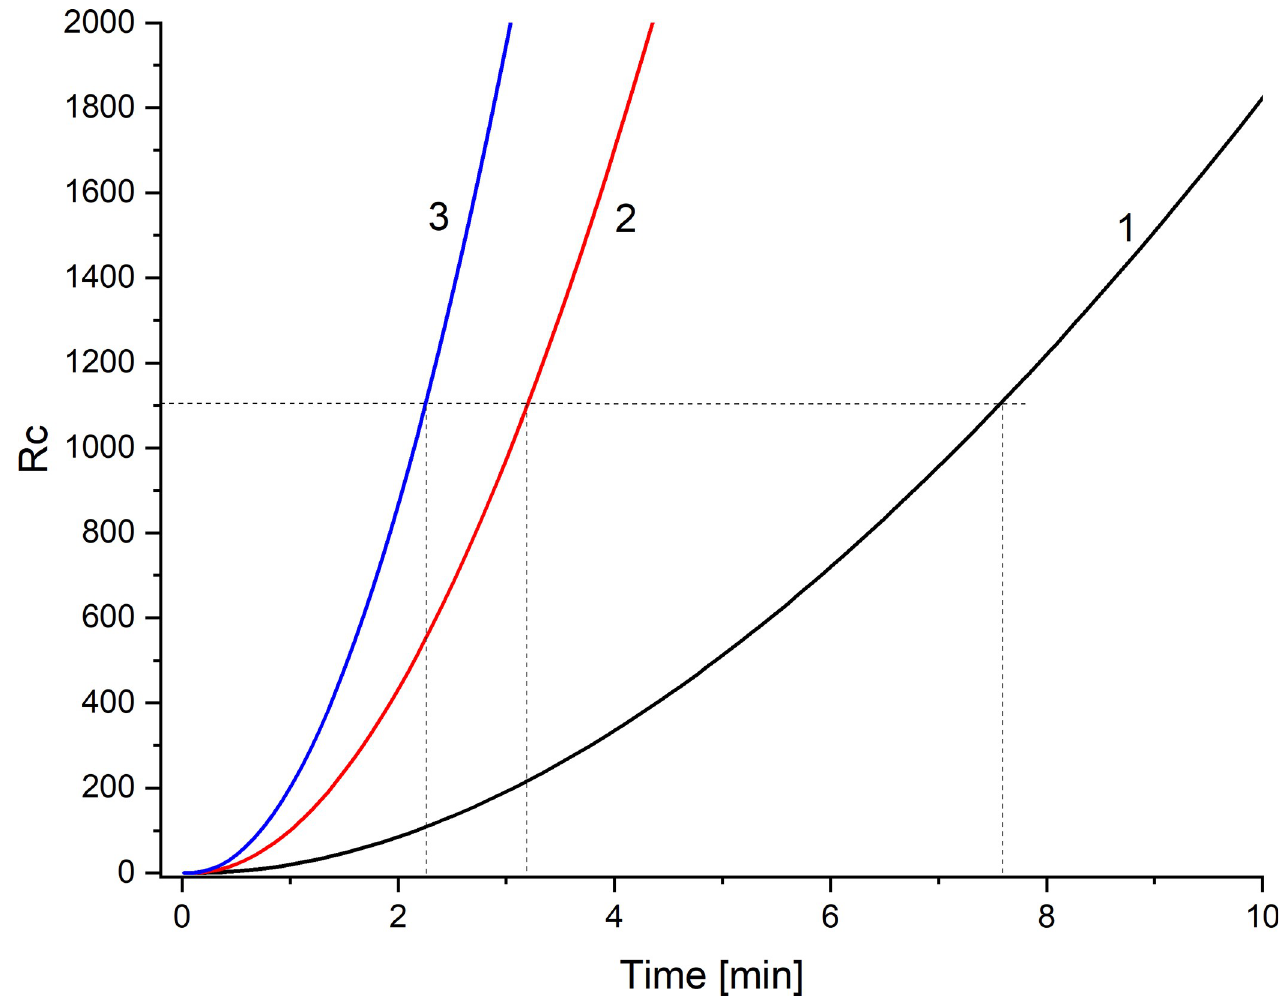
Fig 10. Concentration Rayleigh number as a function of CBL reconstruction time, for initial concentration quotients on the membrane C h / C l = 100 (1), 500 (2) and 1000